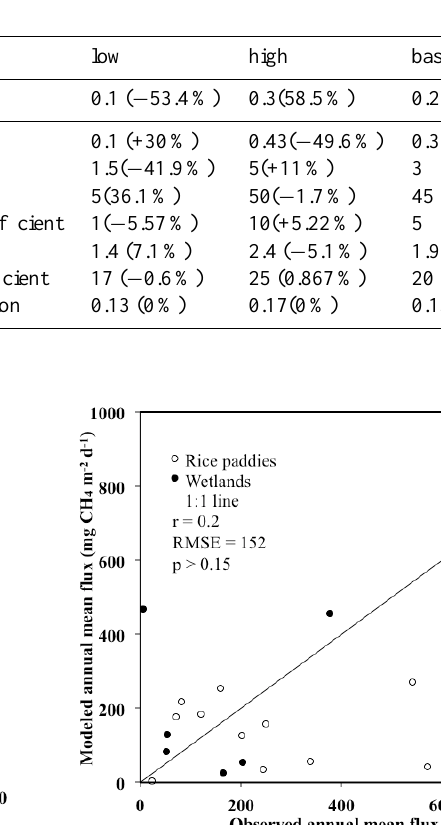
Table 5. Results from sensitivity test for the Panama site. Percentage values in parentheses are relative to the simulations using the base values.